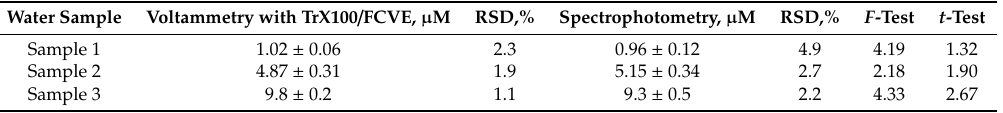
Table 6. Results of NO 2 − determination in water samples applying the TrX100 / FCVE and the UV-spectroscopic method ( n = 3, p =